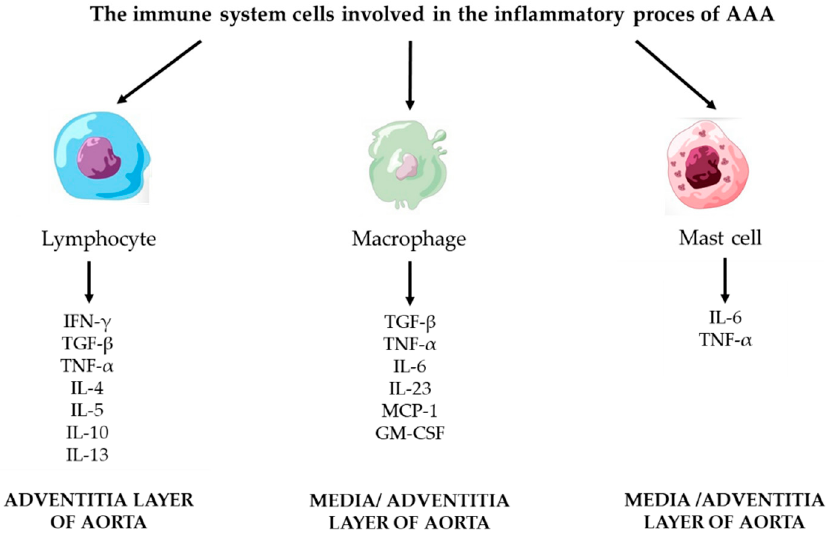
Figure 3. The immune system cells with mediators involved in the inflammatory process of